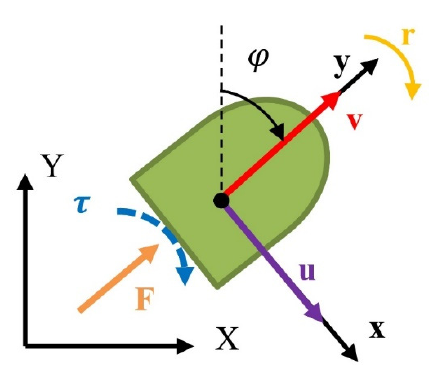
Figure 3. Dynamic model of an ASV with three degrees of freedom.